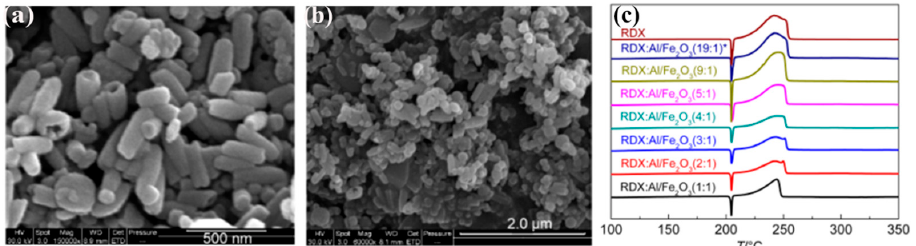
Figure 5-9. ( a , b ) SEM images of nano-Fe 2 O 3 and superthermite Al/Fe 2 O 3 ; ( c ) DSC curves of RDX and RDX/superthermite (Al/Fe 2 O 3 ) mixture. ( a – c ) Reproduced with the permission of ref. [153]. Copyright 2013, Acta Physico-Chimica Sinica.